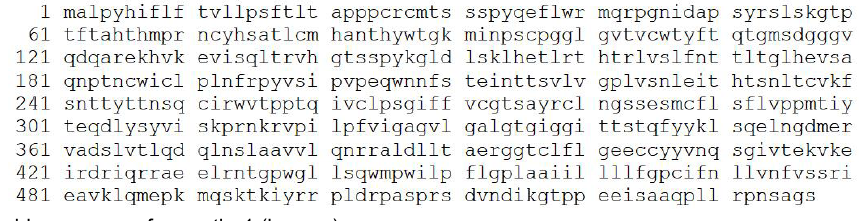
Figure 3. Amino acid sequence of syncytin-1 (human)